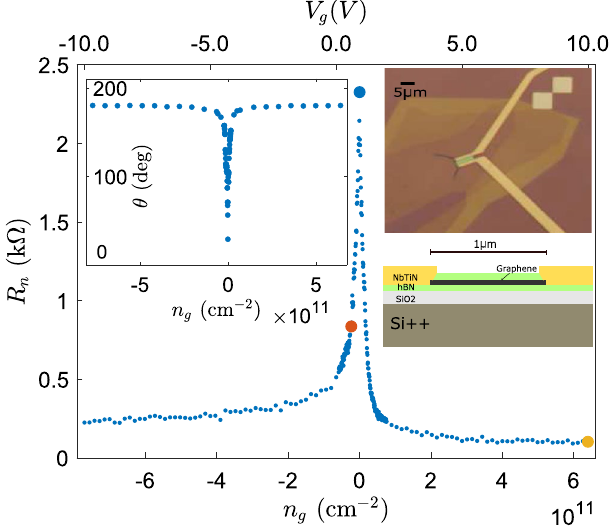
Figure 1. Zero-bias resistance R n versus gate-induced charge carrier density n g measured in the normal state at 15 K. Larger dots denote points at which low frequency noise of the SGS junction was studied temperature T = 2 2.3 10 10 cm 0.6 V, red), (2) charge neutrality point ( V D in detail: (1) n g ( V g − = − × = 2 6.4 10 11 cm 10 V, yellow). Left inset: Reflection phase θ versus gate-induced charge carrier n g ( V g − = × = density n g . Right inset: Optical microscope image and cross-section schematic of the investigated two-lead sample: the width of the junction is 5 µ m while the length amounts to 1 µ m. The yellow leads denote the NbTiN contacts. A 5 µ m scale bar is indicated in the microscope